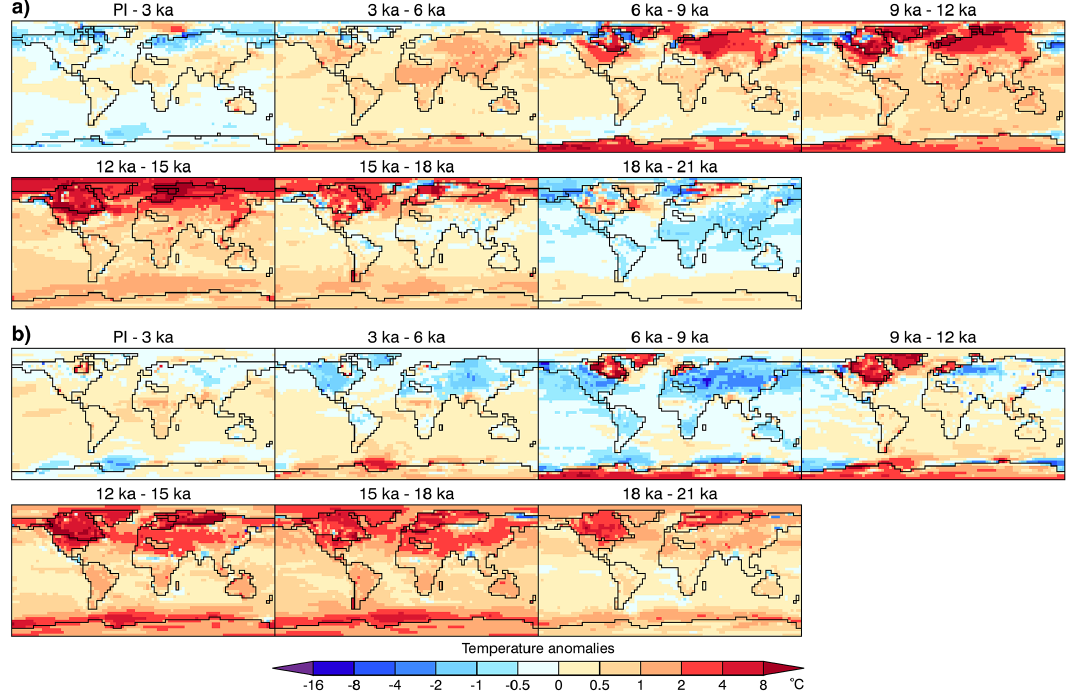
Figure 7. Simulated seasonal average changes in 2m air between consecutive time slices. (a) December, January, and February and (b) June, July, and